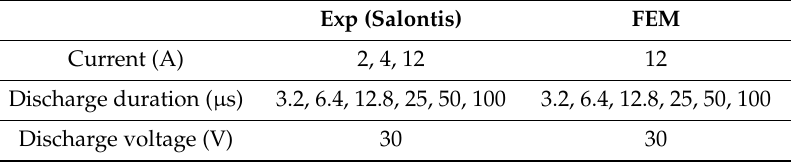
Table 2. Performance parameters of surface roughness